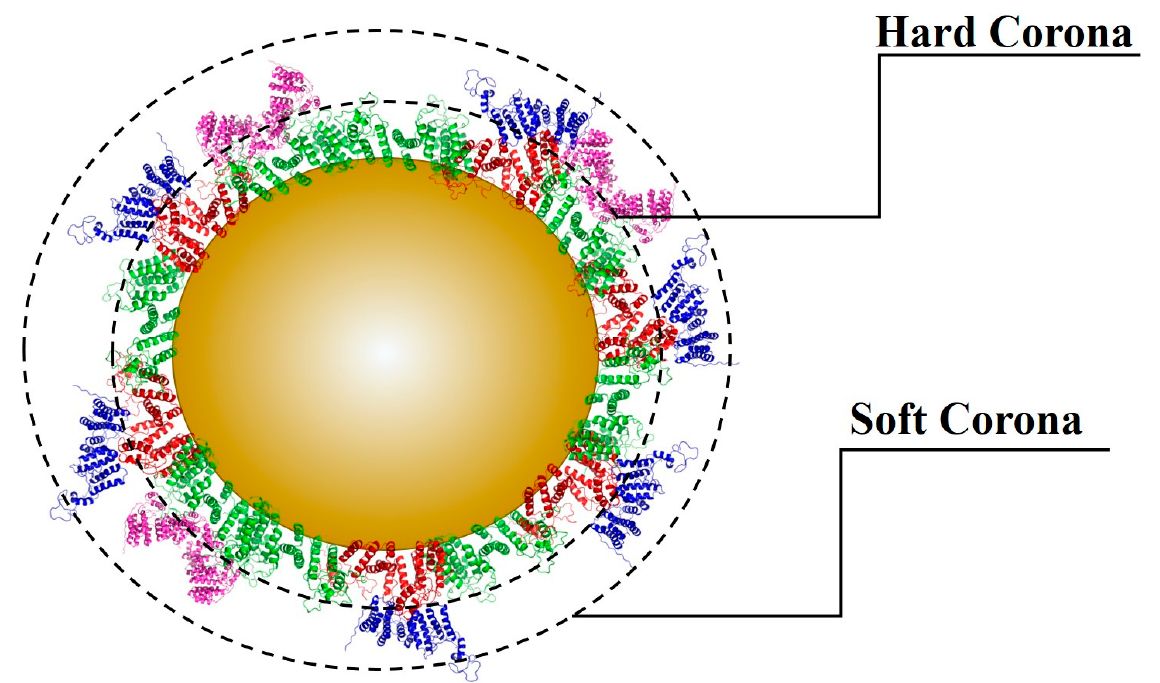
Figure 3. Protein corona consists of two layers: the hard corona is an inner layer composed of high-affinity proteins, and the soft corona is an outer layer that is weakly bound by low-affinity proteins not directly bound to the nanomaterial.